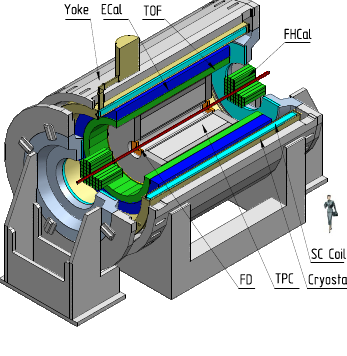
Figure 1. Geometry of MPD Stage I